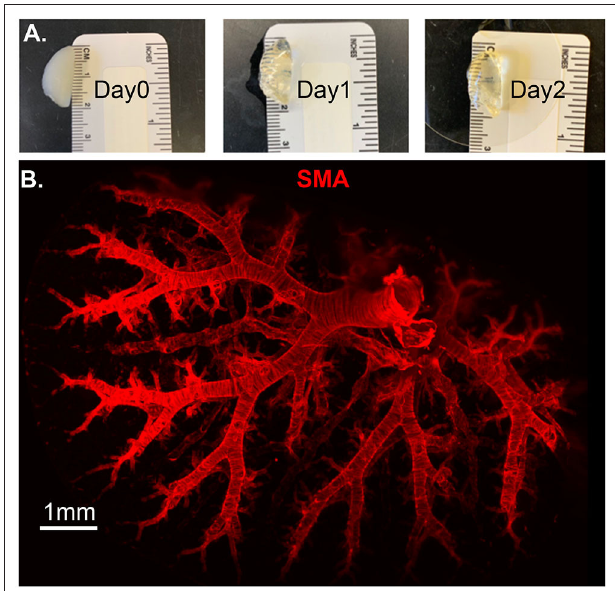
FIGURE 5 | Lung structure staining by smooth muscle actin (SMA) staining. Wildtype mouse whole lung lobe was gradually and optically cleared (became transparent) in 2 days with organic solvent BABB (A) and imaged using 3D Light Sheet (B)